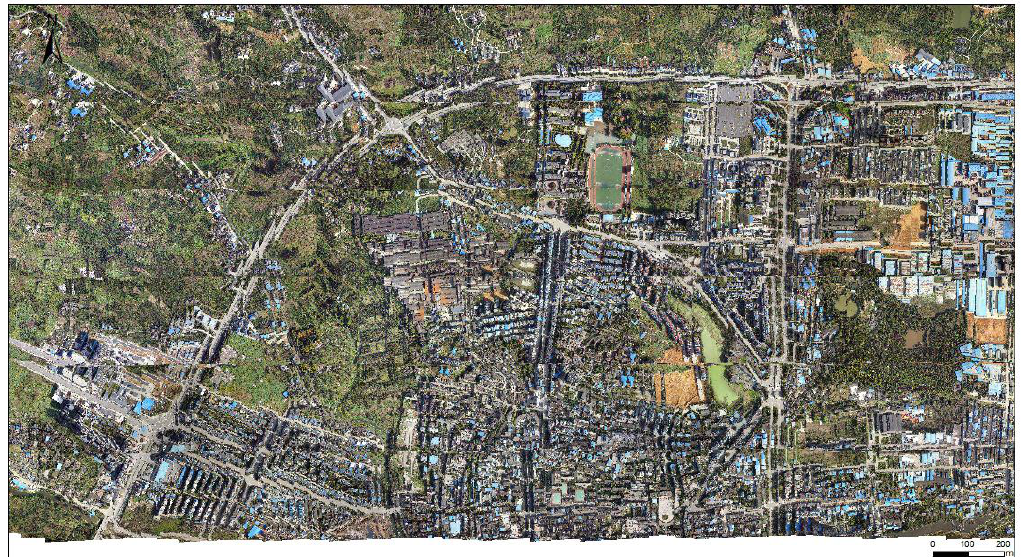
Figure.3 The result of UAV images rapid geographical